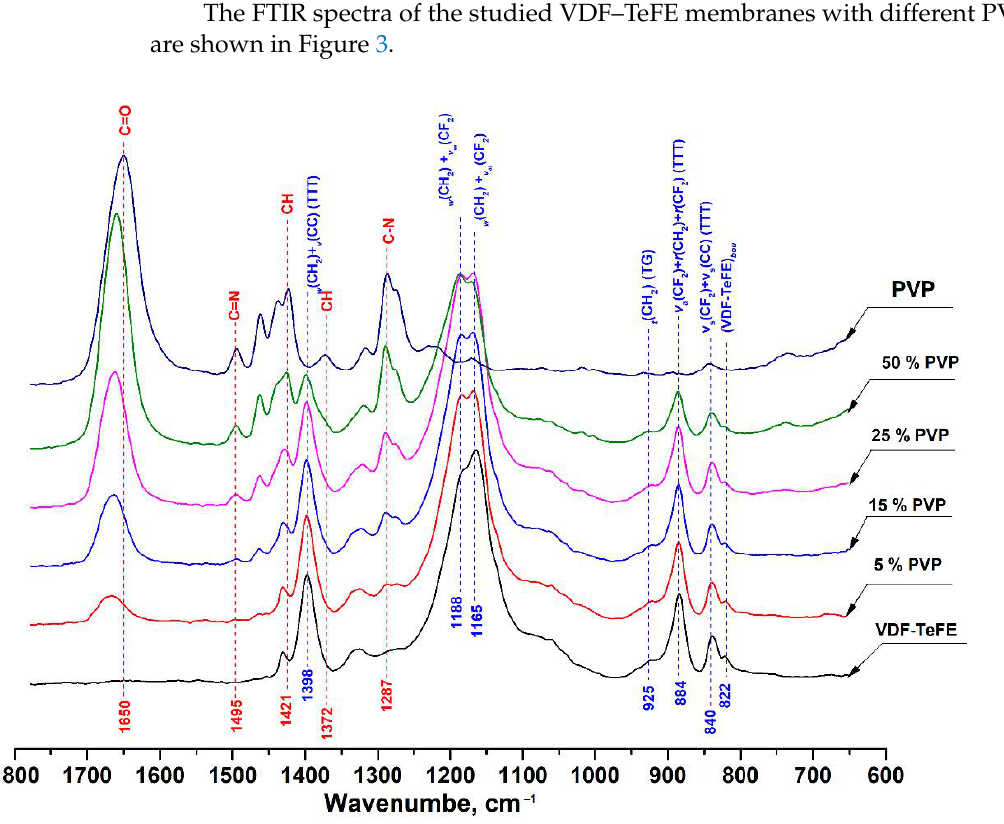
Figure 3. FTIR spectra of composite VDF–TeFE/PVP membranes with different PVP contents.